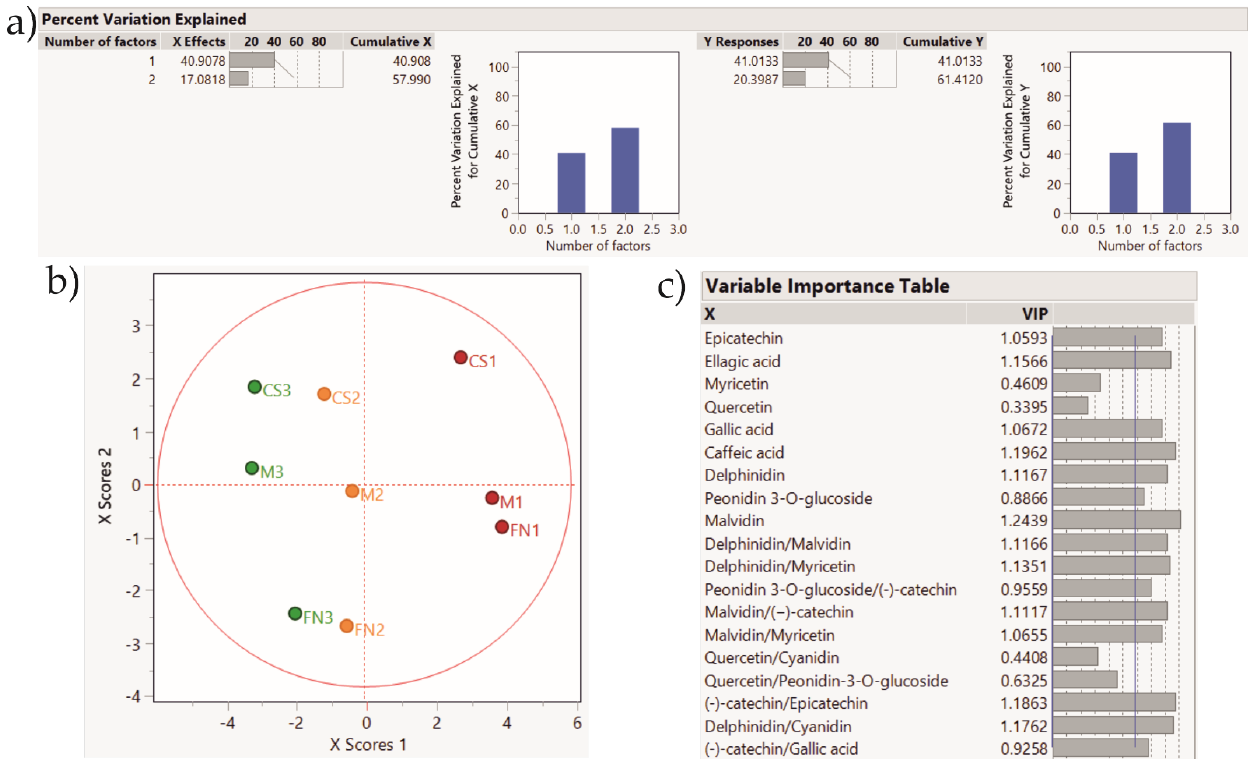
Figure 8. PLS-DA score plot showing sample clustering for Stage 3 wines. Color coding: red—Murfatlar 2014; orange— Murfatlar 2015; green—Valea Călugărească 2015. ( a ) Percent of variation explained by the two factors; ( b ) PLS-DA score plot; ( c ) VIPs (Variable Importance for the Projection) showing the predictors and their importance in determining the PLS projection model.